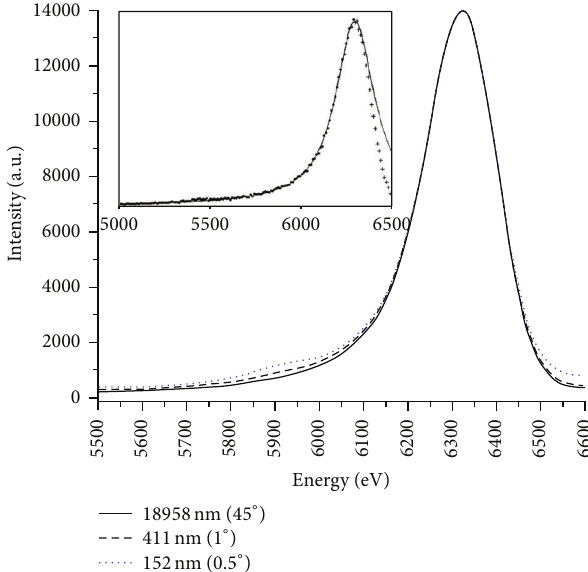
Figure 4: Comparison between Raman spectra obtained at three different observed depths in sample B. Inset: example of Lorentzian fit in the Raman tail.